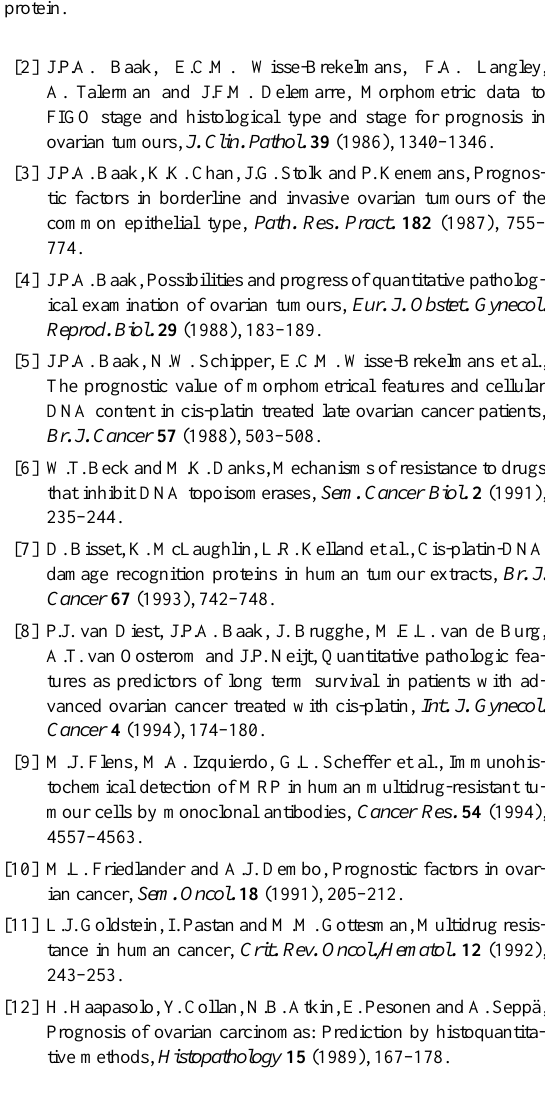
FIGO stage and histological type and stage for prognosis in ovarian tumours, J. Clin. Pathol. 39 (1986),